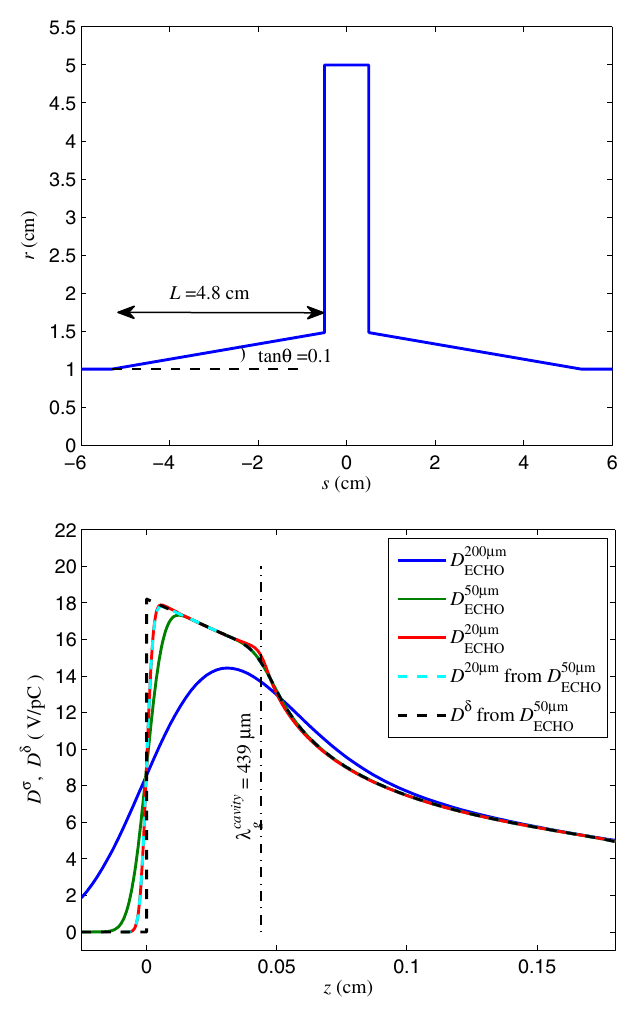
FIG. 10. Wakefield reconstruction for tapered cavity geometry shown on